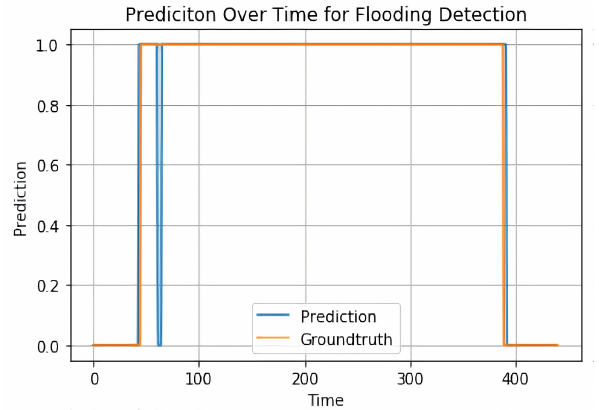
Figure 9. The final prediction of the flooding detection model. 1 means there is flooding while 0 means there is no